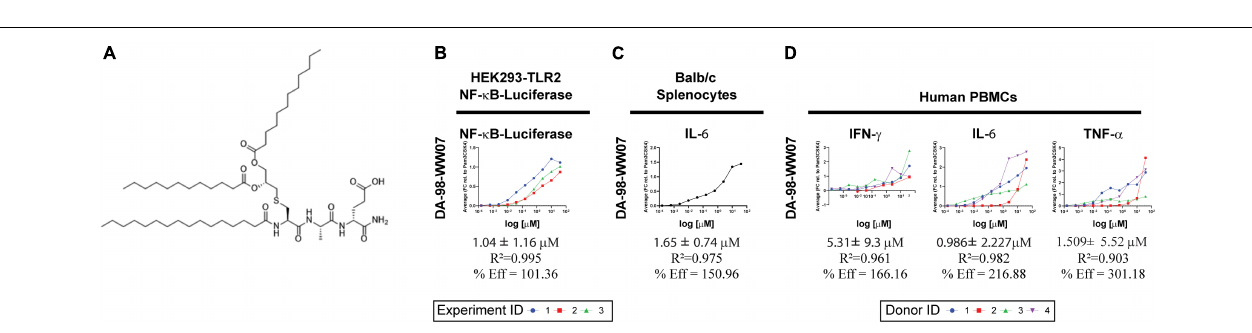
FIGURE 2 | Toll-like receptor (TLR) agonists induced various level of resistance to B. anthracis infection. Kaplan-Meier curves of C57BL/6 mice infected with B. anthracis . Mice are pre-treated with indicated benchmark TLR agonists followed with B. anthracis infection. Statistically significant differences (Log-rank test) in time to death (days) between the treated verses the control are indicated. *** indicates p -value < 0.001. ** indicates p -value < 0.05.